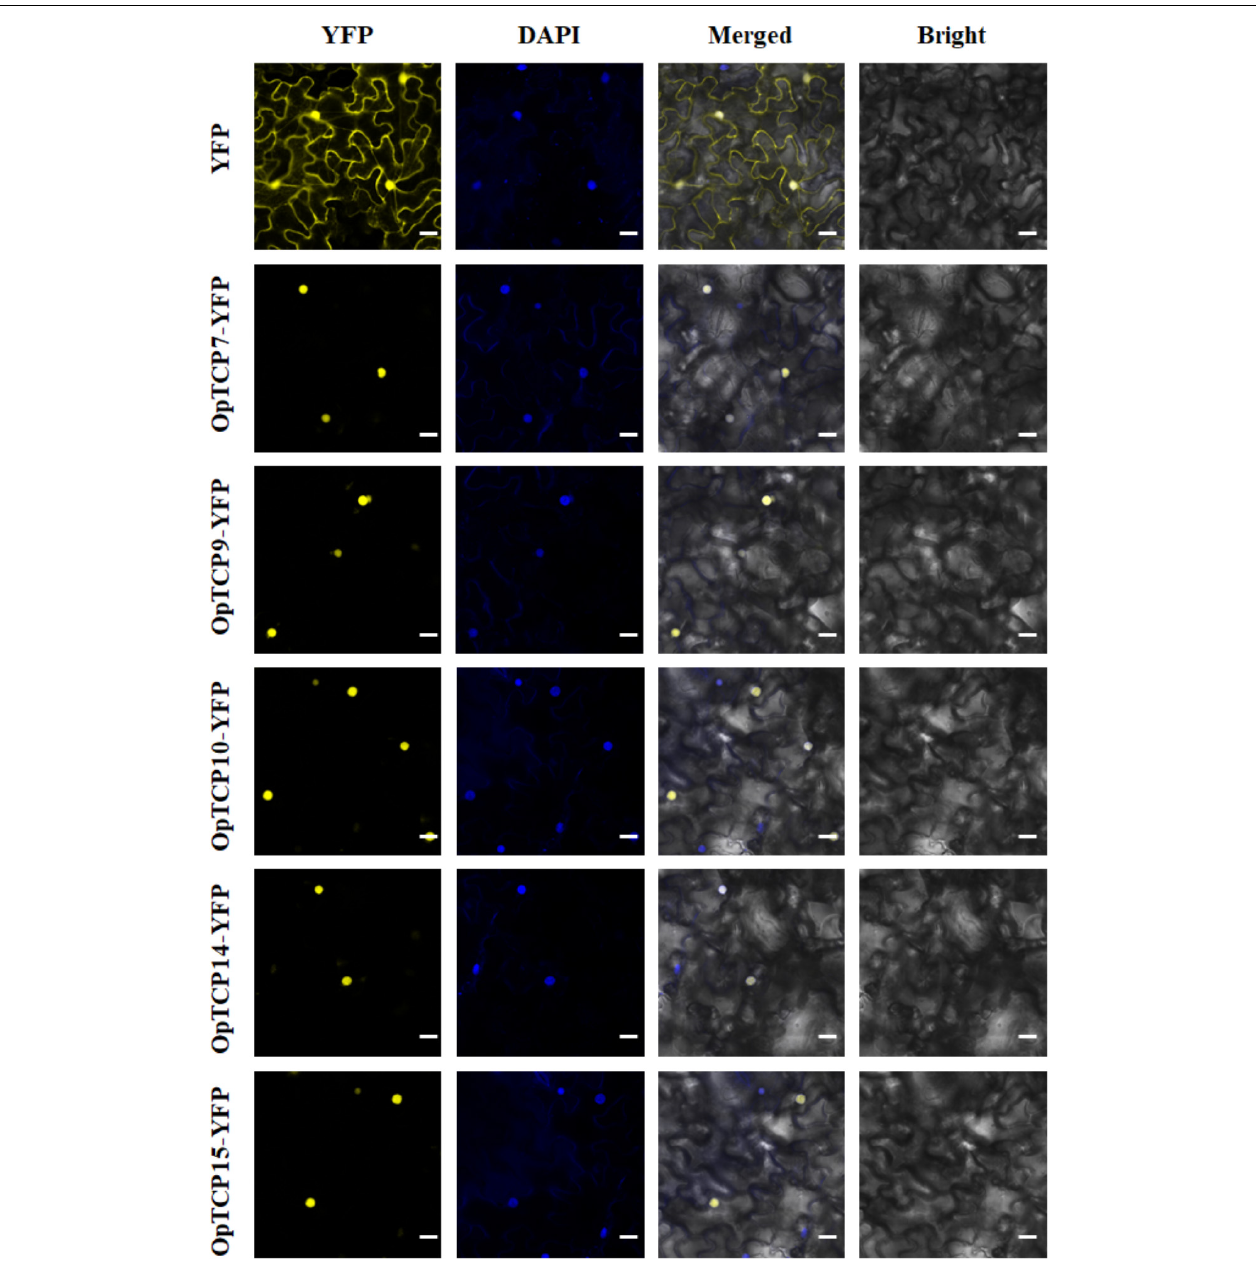
FIGURE 8 | The subcellular localization of the selected five OpTCPs. Scale bars: 20 µ m. OpTCP, O. pumila